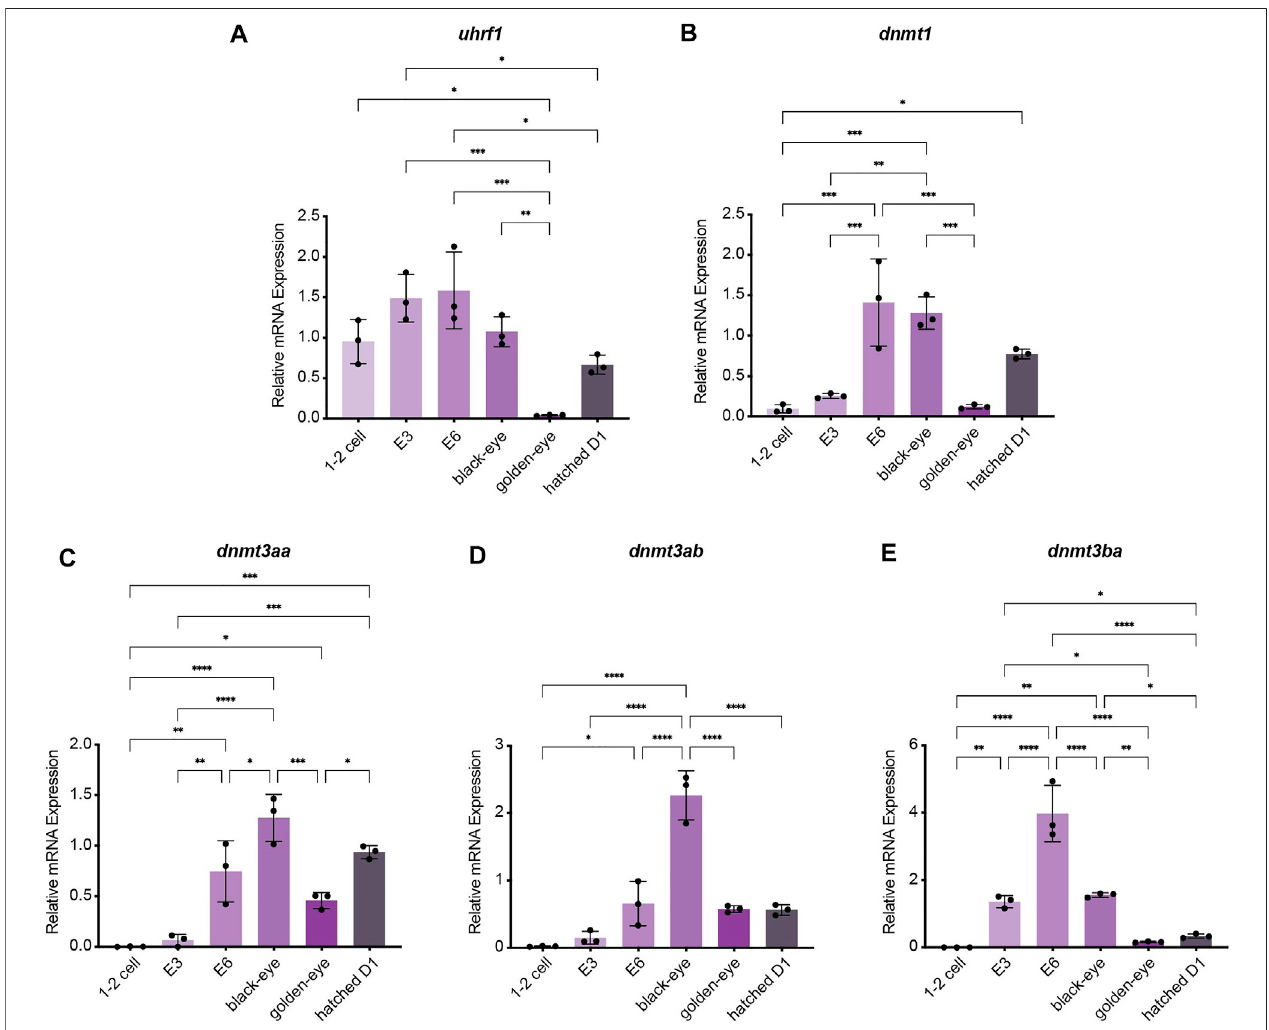
FIGURE 2| Gene expression pro fi lingof killi fi sh DNA methyltransferases and recruitmentfactors during embryogenesis and post hatching measured byReal-time qRT-PCR. DNMT1 recruitment factor uhrf1 (A) , dnmt1 (B) , dnmt3aa (C) , dnmt3ab (D) , dnmt3ba (E) . Individual dnmt/uhrf1 expression was normalized to tbp housekeeping gene expression. For total RNA isolation the following numbers of embryos per biological replicate were sampled (1 – 2 cell: 200 eggs; E3 and E6: 100 eggs; black and golden eye: 50 eggs; hatched D1: 30 fi sh). All error bars represent SD of three biological replicates. Statistical signi fi cances were calculated with one-way ANOVA implementing Tukey ’ s multiple comparisons. All developmental stages (1 – 2 cell, E3, E6, black eye, golden eye, and newly hatched fi sh D1) where compared to each other and relative mRNA expression is depicted. ns: p > 0.05; *: p ≤ 0.05; ** p ≤ 0.01; ***: p ≤ 0.001; ****: p ≤ 0.0001.